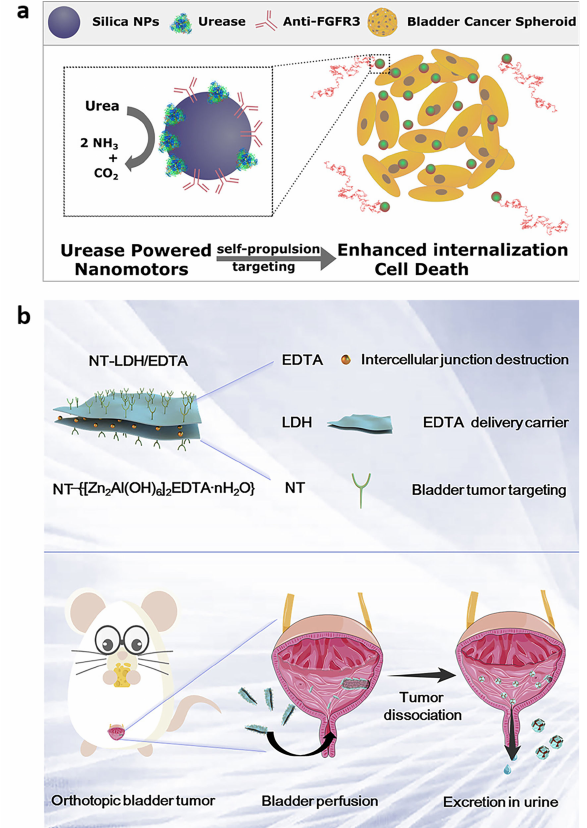
Figure 15. ( a ) Schematic of the urease-powered antibody-modified nanomotors for bladder cancer active targeting and therapy. (Reprinted with permission Ref. [157]. Copyright © 2018 American Chemical Society.) ( b ) Schematic illustration of ethylene diamine tetraacetic acid (EDTA) loaded neurotensin (NT)-modified Zn-Al layered double hydroxide (LDH) for bladder tumor disaggregation. (Reprinted with permission Ref. [158]. Copyright © 2020